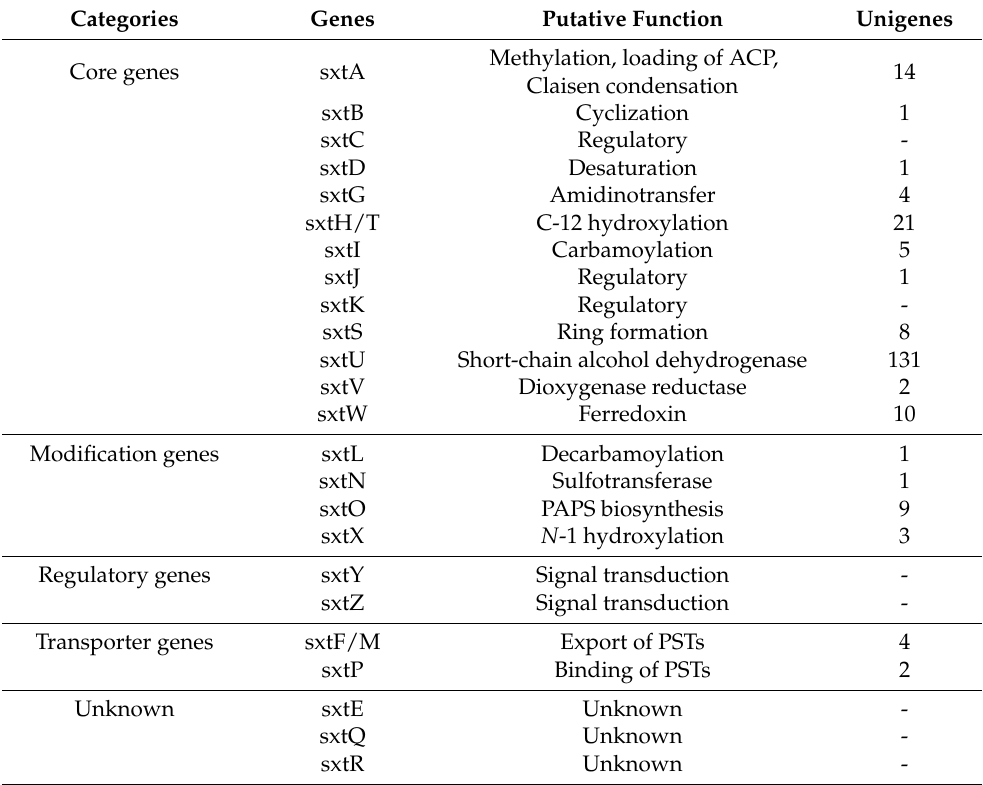
Table 3. The identification of the A. minutum unigenes encoding homologues for proteins involved in the biosynthesis of cyanobacterial saxitoxins using the blastx with an E value <